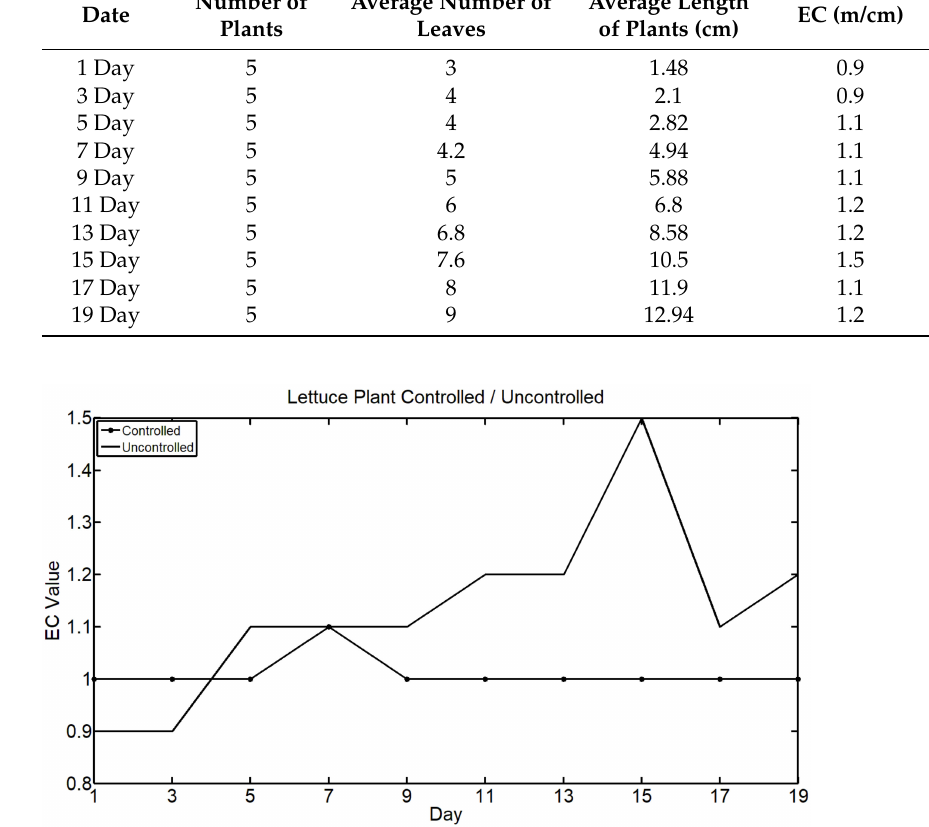
Figure 9. Comparison of lettuce EC values over 19